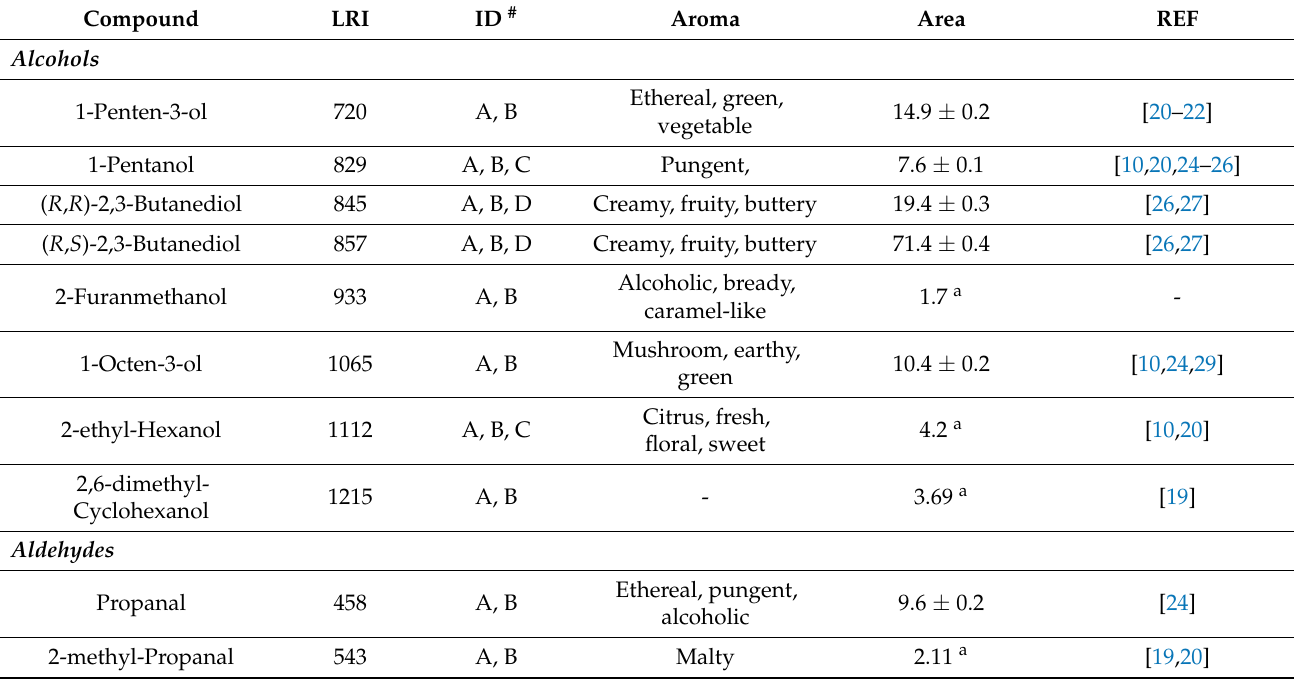
Table 2. VOC composition of bleached melon pomace at t 0 time (M_B_O_t 0 ), identified through HS-SPME-GC-MS analysis, grouped by chemical classes. Data are expressed as mean ( n = 3) TIC area × 10 6 ± SD (3) .